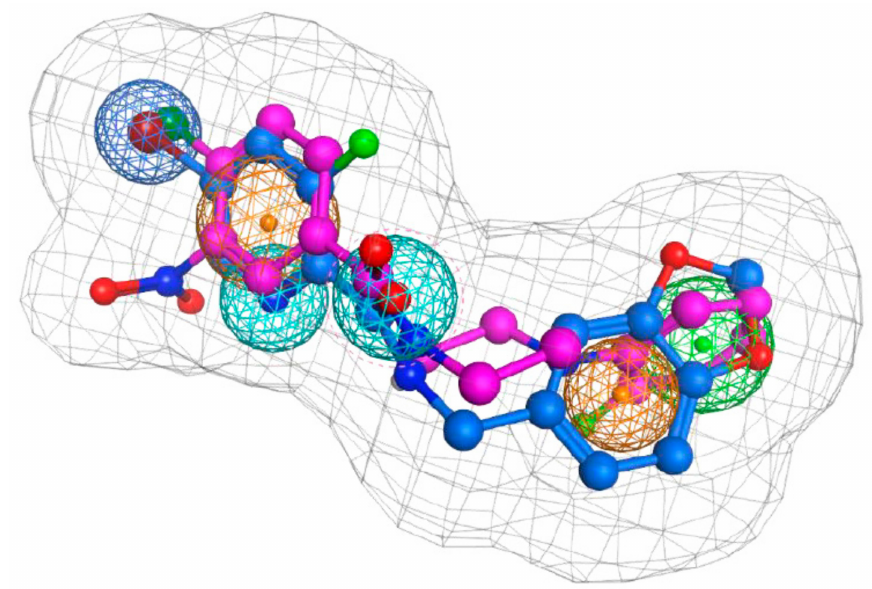
Figure 8. Sec14 Small molecule inhibitor pharmacophore. A Sec14 pharmacophore that describes key features of inhibitor binding to Sec14 is presented. This profile is based on detailed analyses of inhibitors derived from NPPM (magenta) and picolinamide (blue) scaffolds. The pharmacophore features a halogen bond center (blue meshed sphere), aromatic centers (orange meshed sphere), H-bond acceptors (cyan meshed sphere), hydrophobic centers (green meshed sphere), and ligand volume (grey mesh covering the ligand